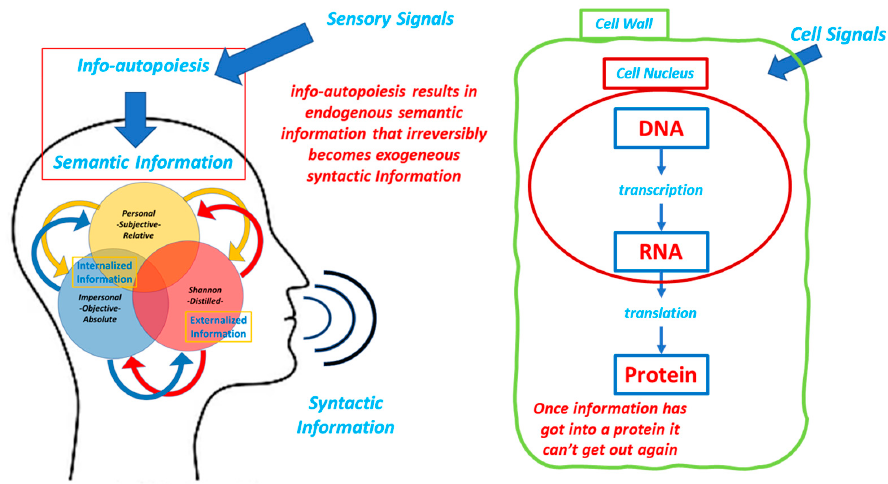
Figure 7. A comparison between info-autopoiesis and genomic flow of information.